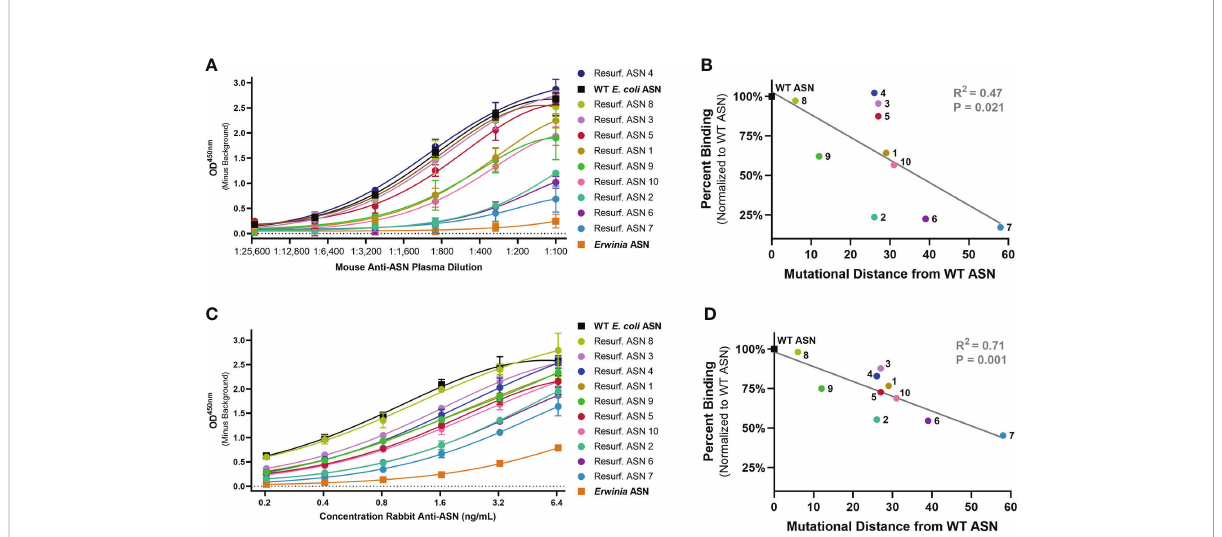
FIGURE 3 Re-surfaced ASN ’ s exhibit reduced binding to polyclonal mouse and rabbit ADAs. An enzyme-linked immunosorbent assay (ELISA) was utilized to monitor relative binding of polyclonal murine and rabbit ADAs to Resurf. ASN variants. Relative binding curves as shown with raw OD 450 values across serial dilutions of (A) primary mouse plasma or (C) puri fi ed rabbit antibodies with mean and standard deviation shown for technical triplicate measures. ASNs are listed in order of highest to lowest titer with WT ASN shown as a black box, the negative benchmark control Erwinia ASN shown as an orange box. The mean binding normalized to the WT ASN control of (B) mouse serum at a 1:300 dilution and (D) polyclonal rabbit anti-ASN ADAs at 3.2 ng/mL to each ASN variant is plotted against the mutational distance from WT ASN. Linear regression analysis demonstrates a signi fi cant negative correlation between binding and mutational distance across both species, R 2 = 0.47 and P <0.05 for mouse serum and R 2 = 0.71 and P = 0.001 for rabbit ADAs. Data are representative of N = 2 independent experiments.